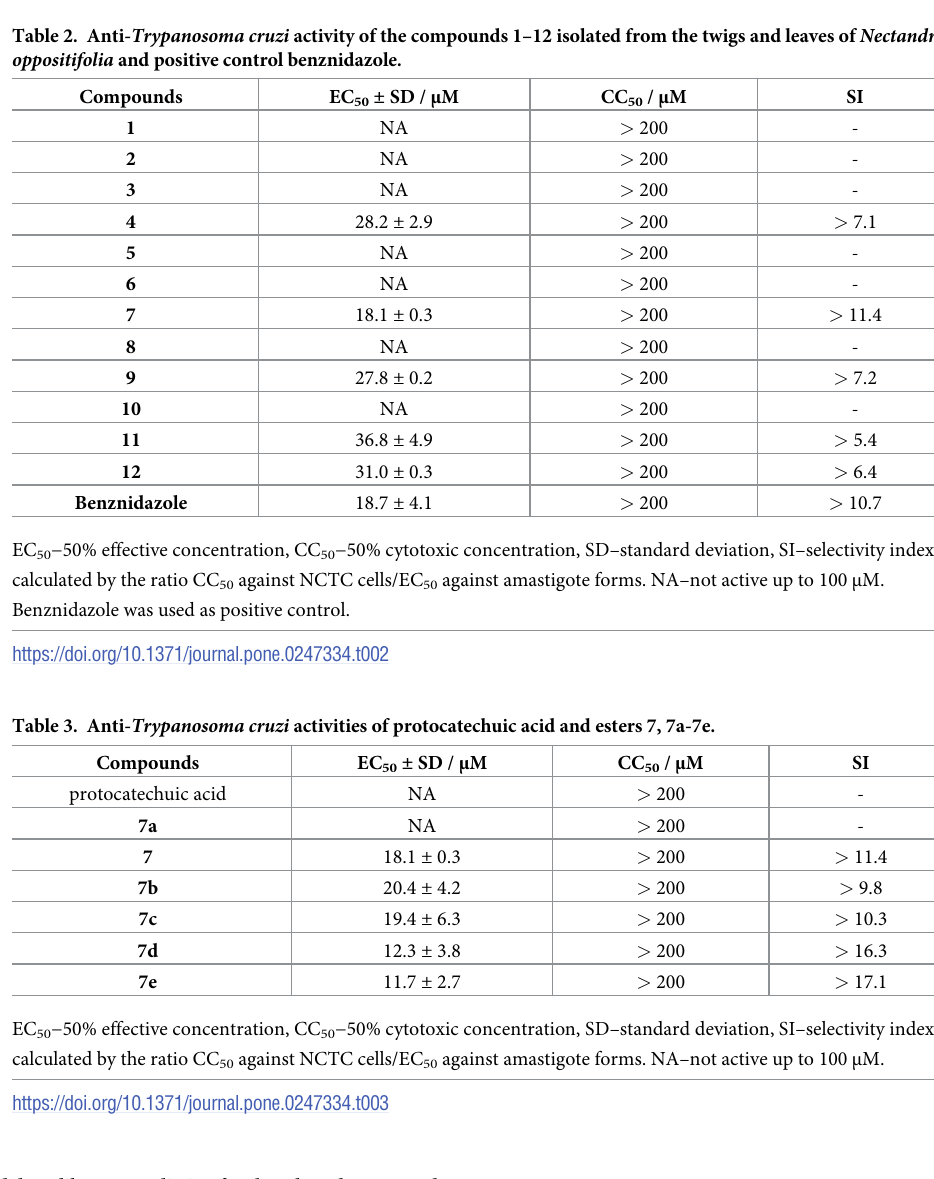
Table 4. Physical chemical, pharmacokinetic and drug-likeness prediction for the selected compounds. Compounds Protocatechuic